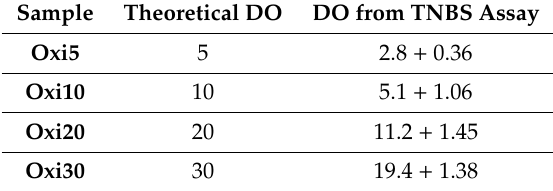
Table 1. Degree of oxidation for the oxidized inulin. DO: degrees of oxidation, TNBS: trinitrobenzene sulfonic acid.